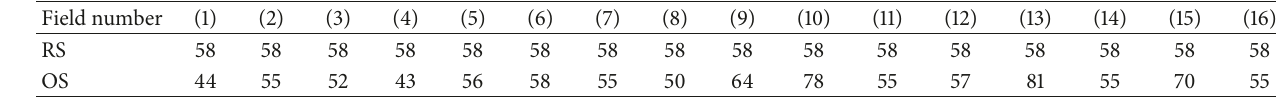
Table 1: The sampling number distribution of OS and